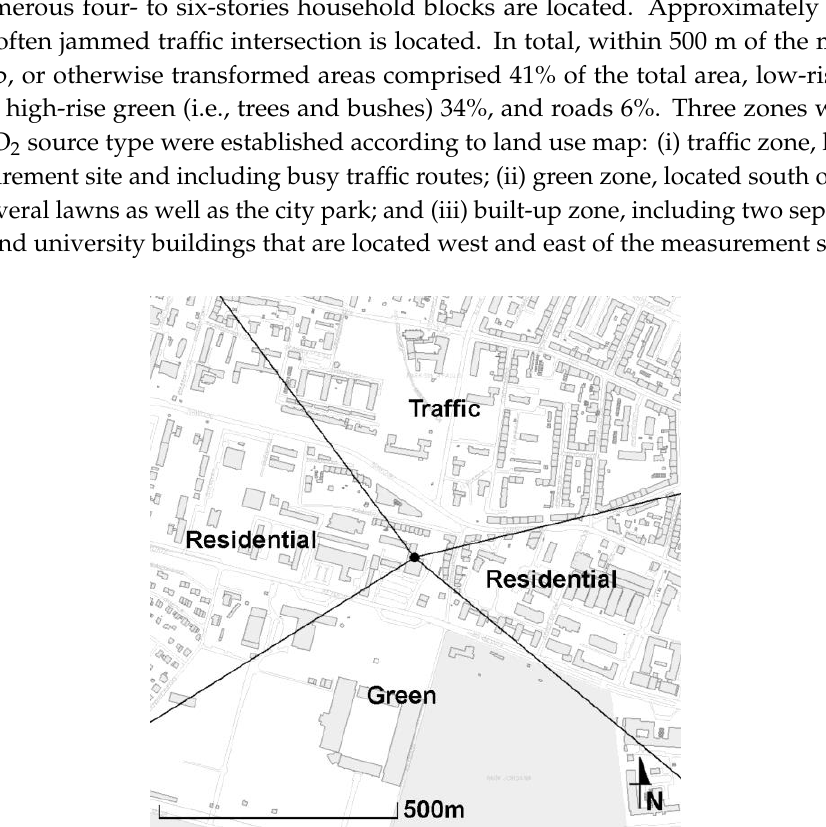
Figure 3. The REA-AGH site marked by black dot in the center of the map and its immediate vicinity, with established CO 2 basic source types (map source: